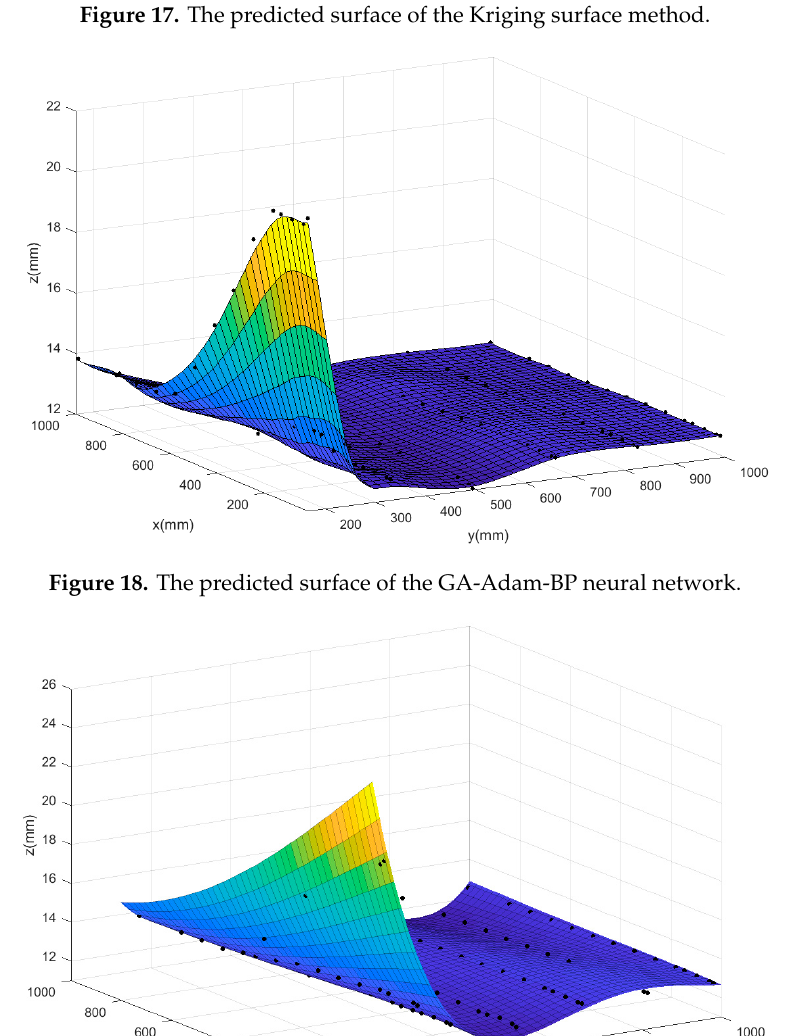
Figure 17. The predicted surface of the Kriging surface method.